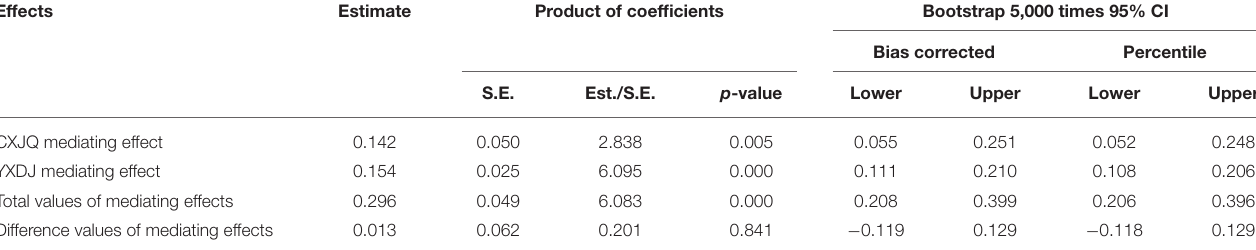
TABLE 12 | Comparison results of mediating